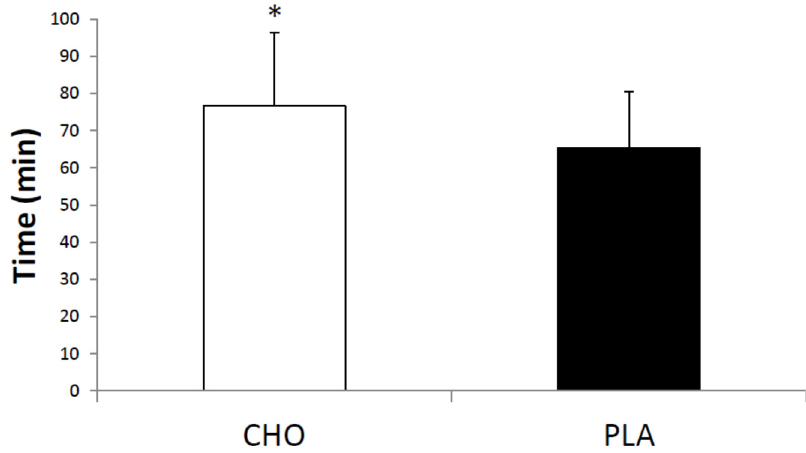
Figure 2. Time (min) to exhaustion during moderate ‐ intensity exercise. CHO = carbohydrate and PLA = placebo. * Different from PLA, p < 0.05.